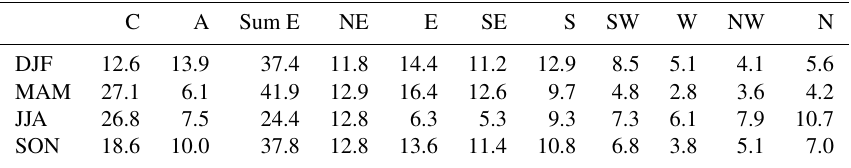
Table 3. Seasonal CWT occurrence frequencies (%) for central Europe (centred at 17.5 ◦ E and 47.5 ◦ N) during the LGM. The frequencies are based on MPI-LGM simulation. The CWT classes are cyclonic (C), anticyclonic (A), northeasterly (NE), and easterly (E) followed by the remaining standard wind directions. Sum E is the sum of the east sector winds (NE, E, SE). The seasons are labelled DJF (winter), MAM (spring), JJA (summer), and SON